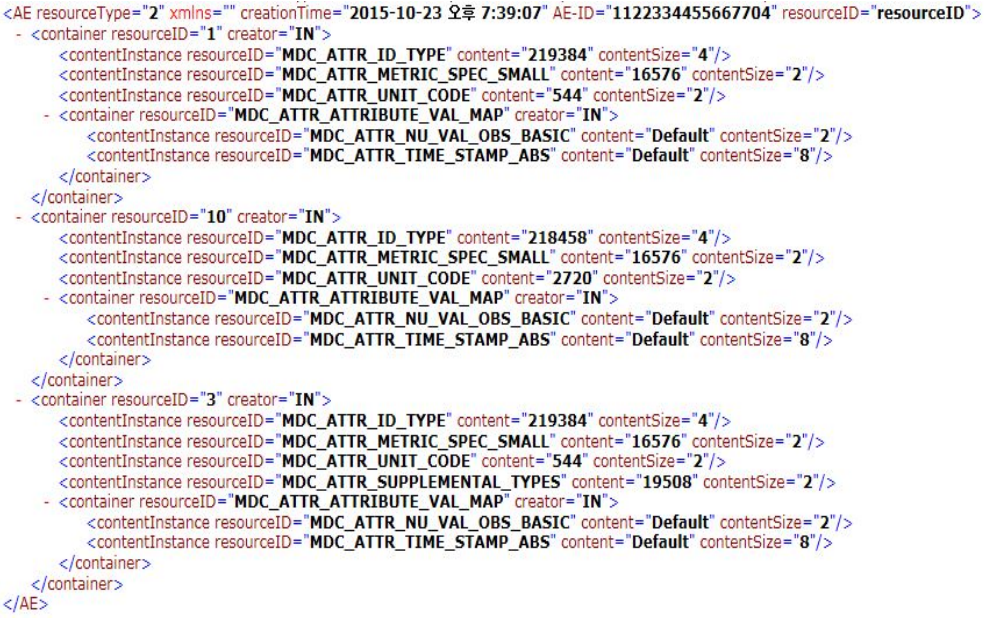
Figure 18. Resource tree created by the IoT server (IN-CSE) after the registration process.